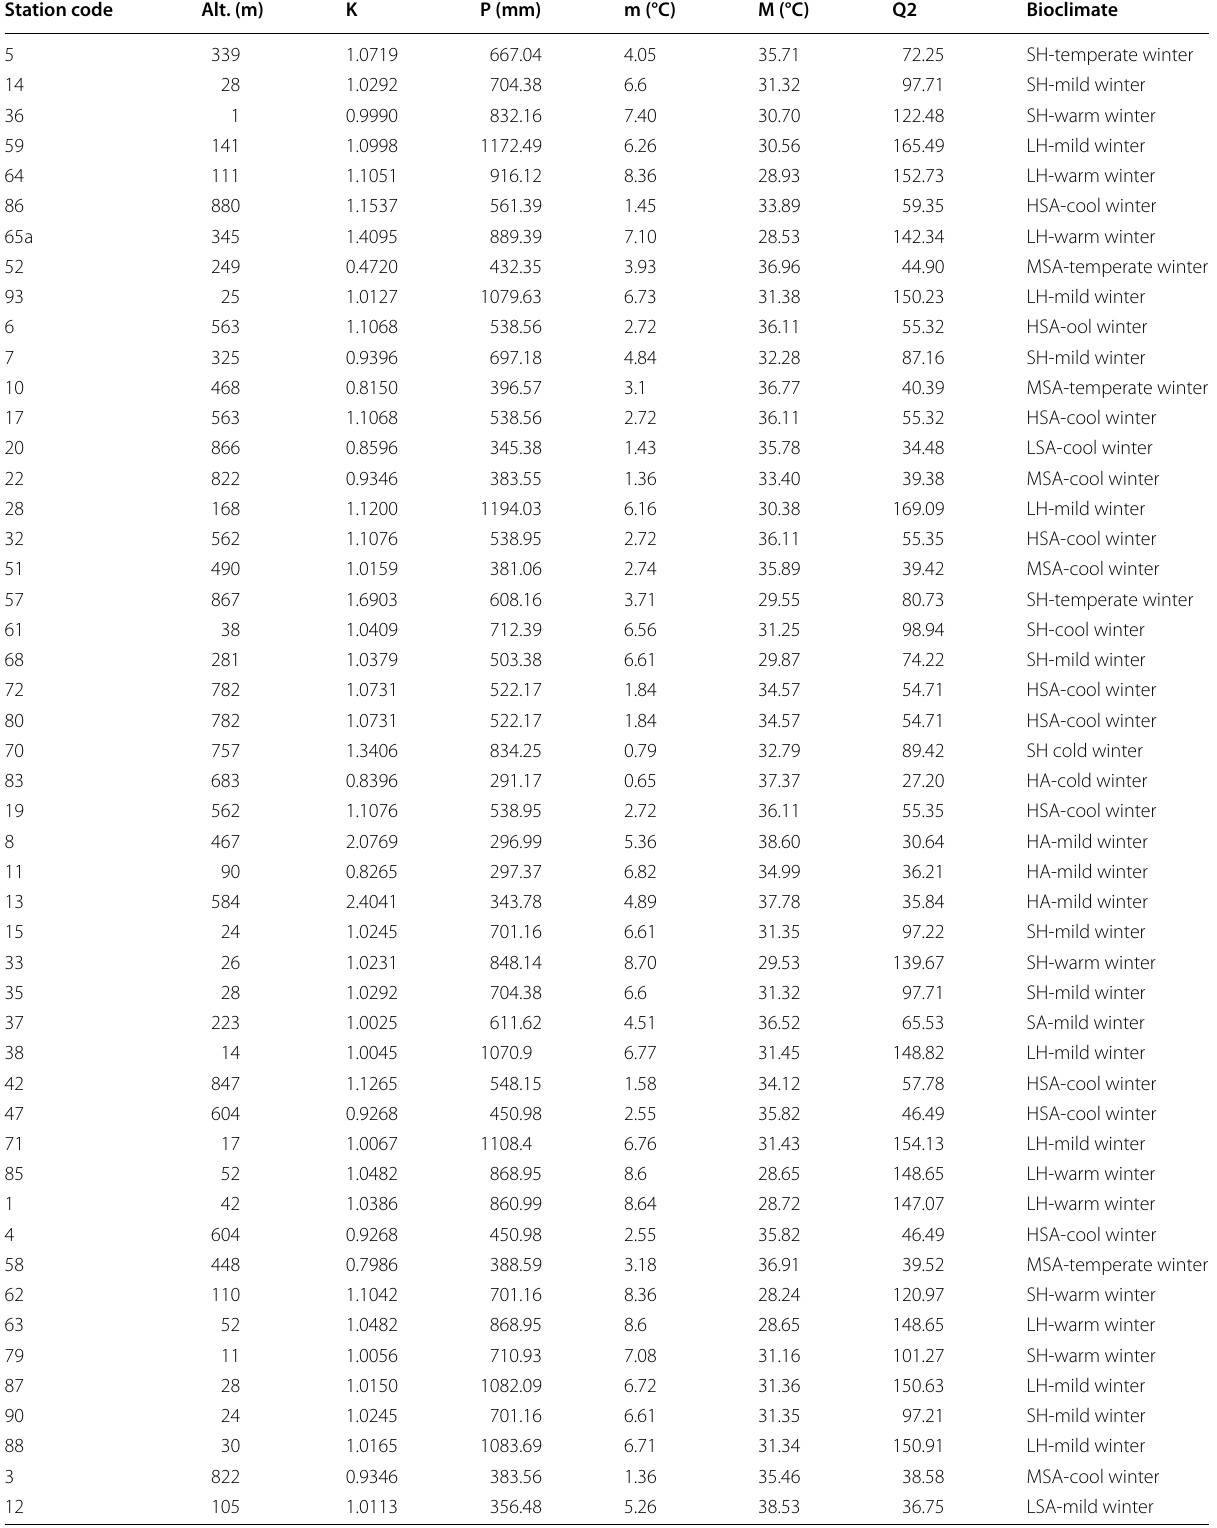
Table 3 Corrected climatic data and Emberger quotient calculation of sampling sites of accessions studied Station